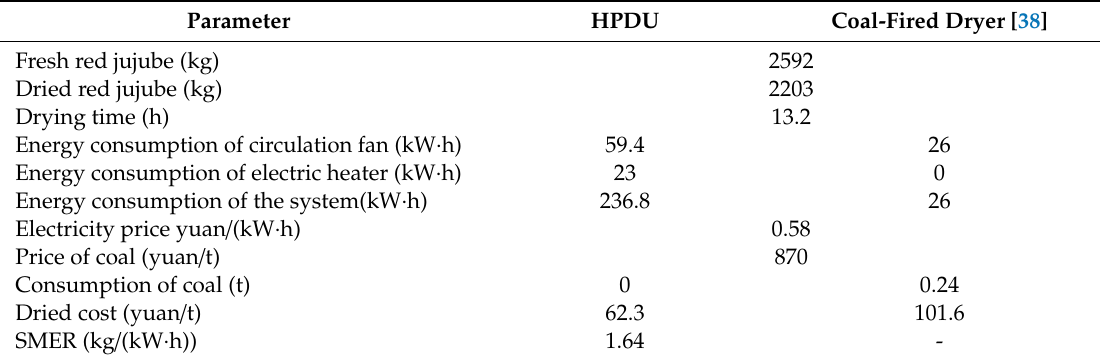
Table 3. The economic analysis of the system.